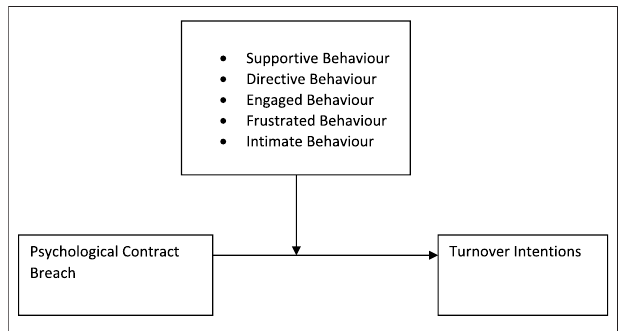
FIGURE 1 | Proposed model for the study. Hypothesized model of the moderating roles of organizational climate dimensions on the associations between psychological contract breach and turnover